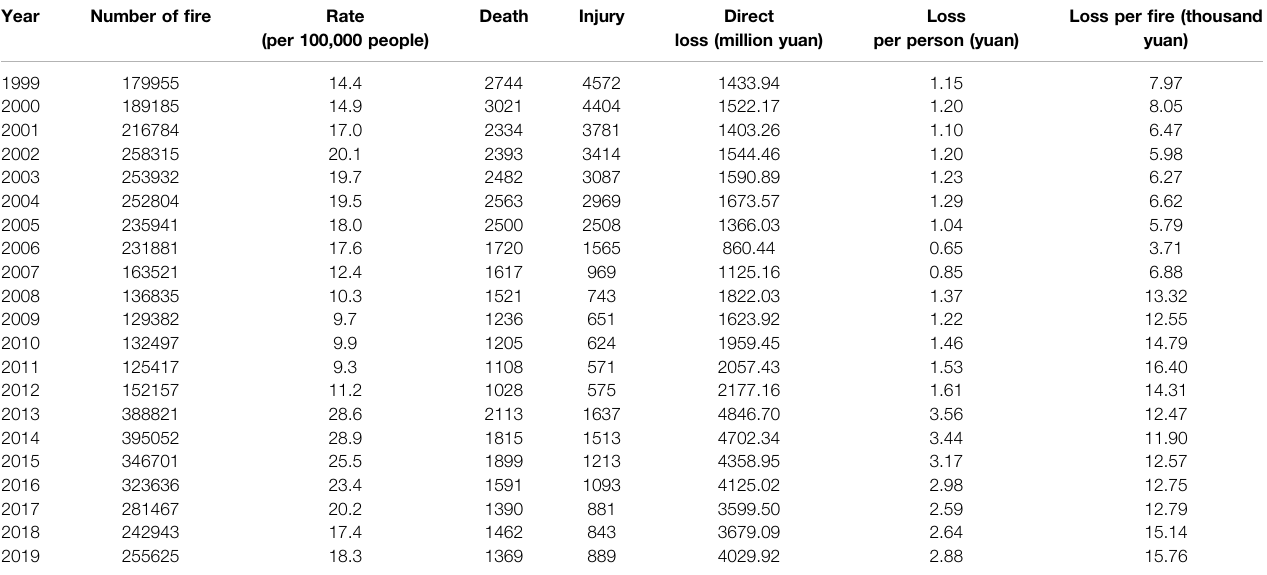
TABLE 3 | China ’ s fi re situation from 2000 to